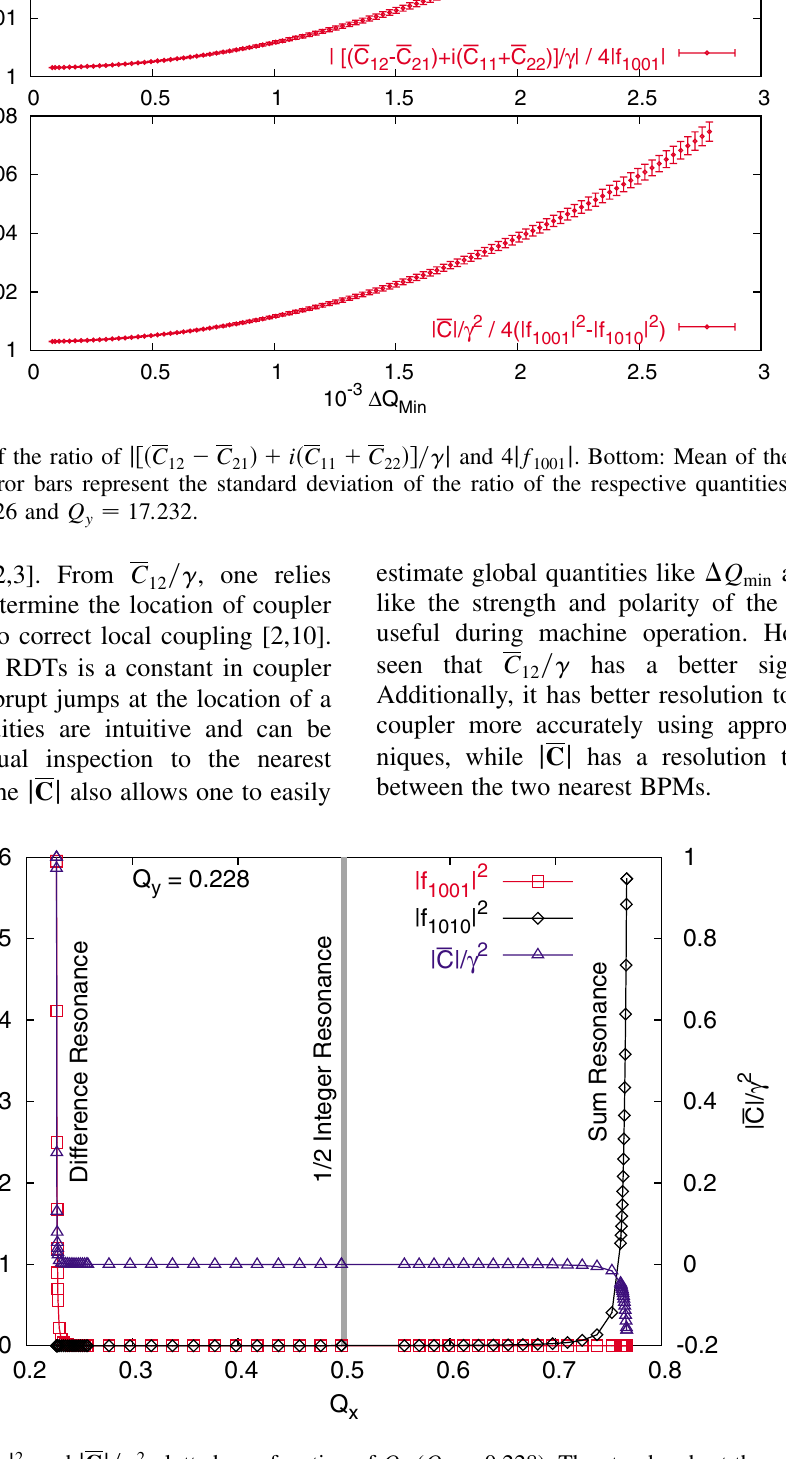
(cid:3) 0 : 228 ). The stop bands at the sum and the difference ( Q x y